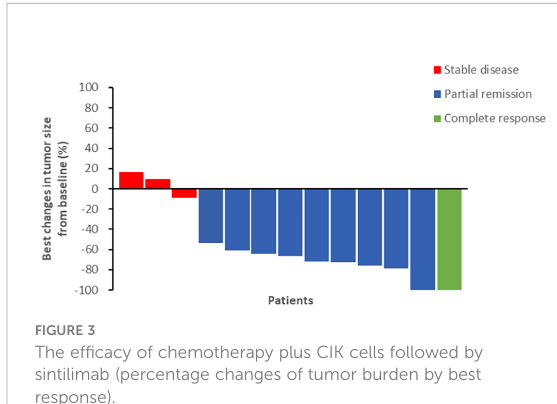
FIGURE 3 The ef fi cacy of chemotherapy plus CIK cells followed by sintilimab (percentage changes of tumor burden by best response).